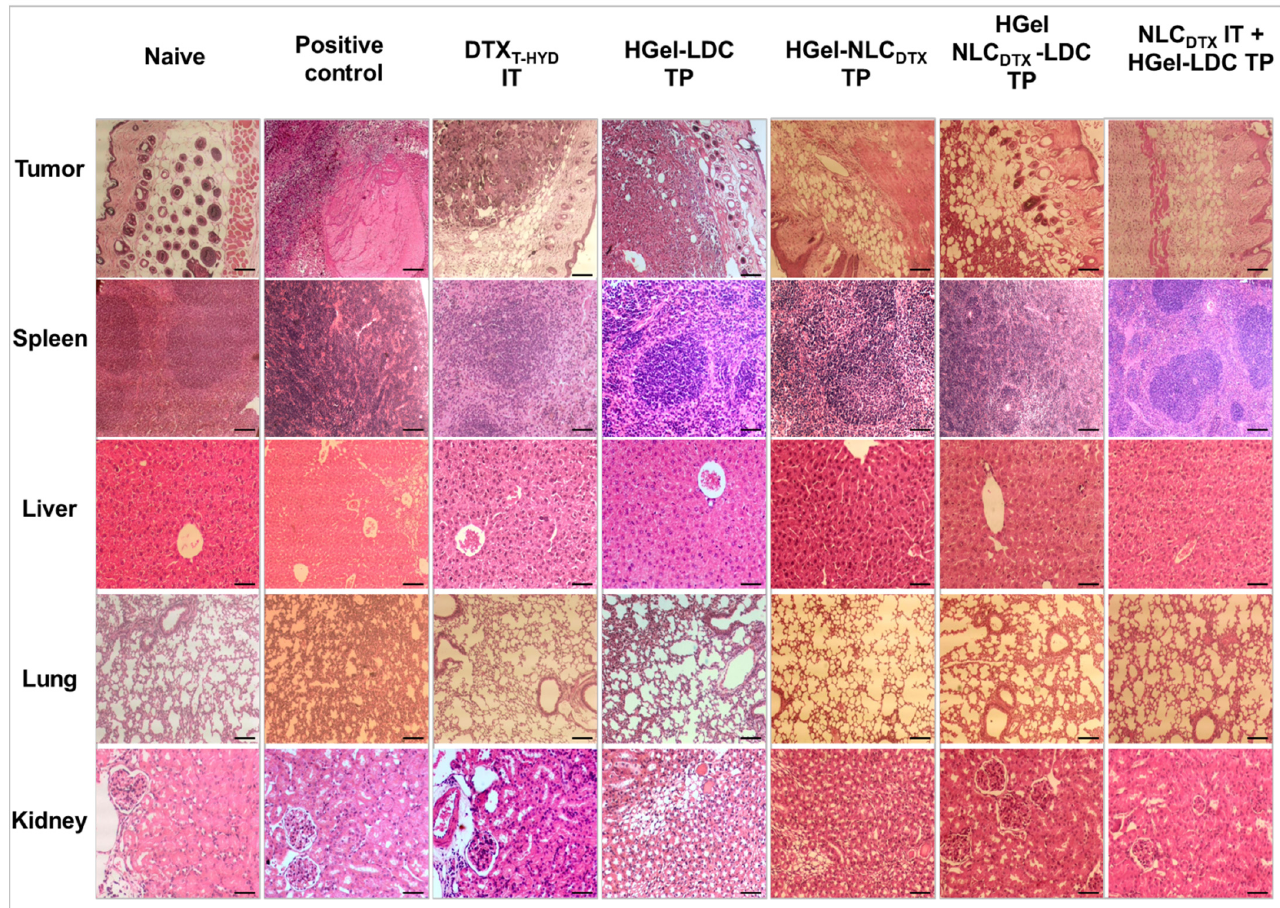
Figure 7. Histopathology sections of female C57BL/6J mice with orthotopically induced cancer (B16-F10 murine melanoma cells (except the naive group) and treated with: DTX T-HYD , HGel-LDC TP, HGel-NLC DTX TP, HGel-NLC DTX -LDC TP and NLC DTX IT + Gel-LDC TP. Analysis of the tumor region, spleen, liver, lung, and kidney; H & E, Scale bar = 50 µ m, magnification: 100× or 400×).